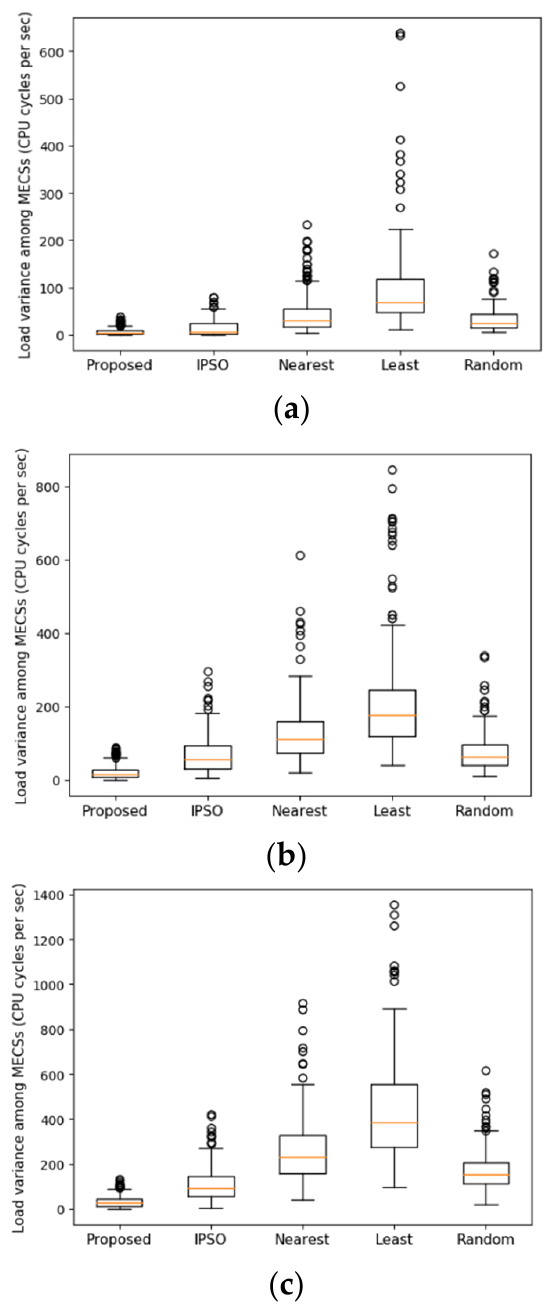
Figure 9. Load variance among MECSs of the five methods; ( a ) vehicle arrival rate = 0.3.; ( b ) vehicle arrival rate = 0.6; ( c ) vehicle arrival rate = 0.9.